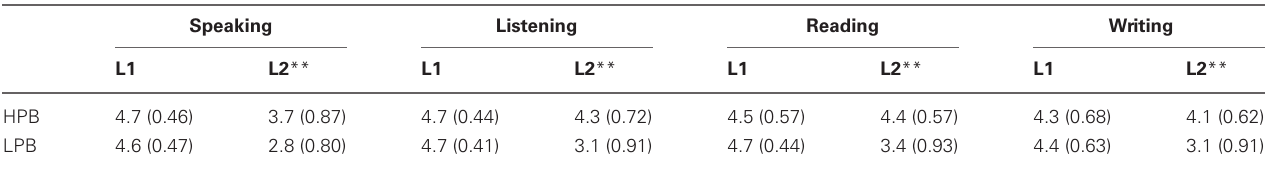
Table 2 | Self-ratings for reading, writing, speaking, and comprehension in L1 and L2.